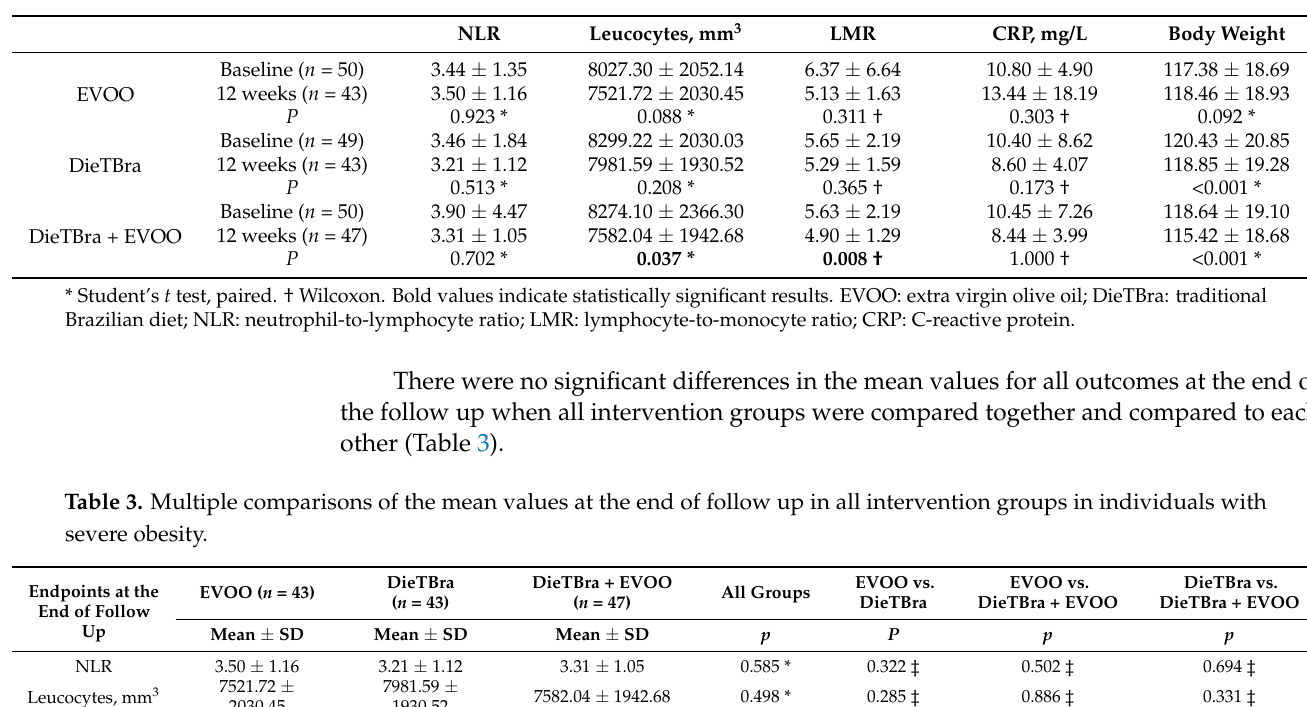
Table 2. Comparison of the mean values at baseline and at the end of the follow up according to intervention groups in individuals with severe obesity.